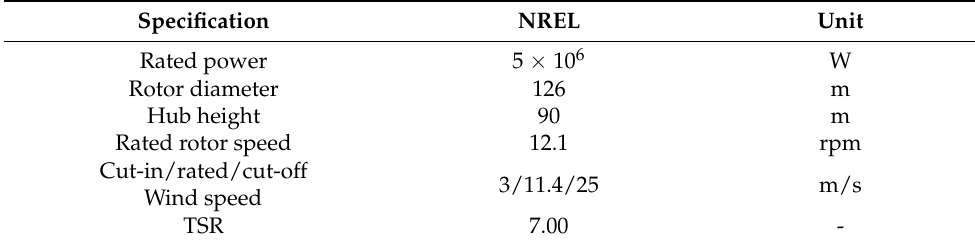
Table 1. General specifications of target wind